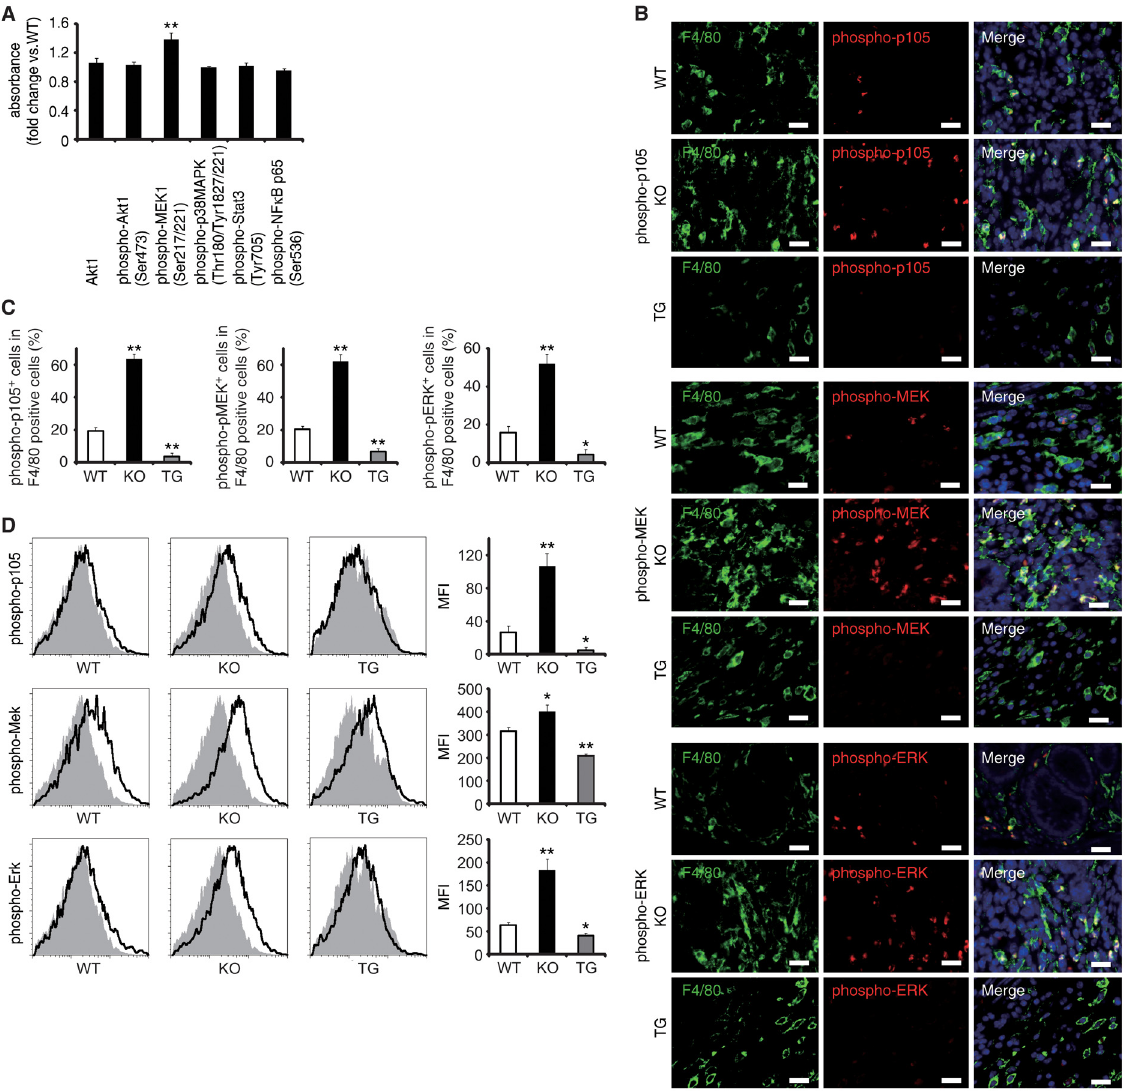
Fig 4. EPRAP inhibits p105 phosphorylation and MEK – ERK activation in stromal macrophages with DSS treatment. (A) The expression levels of Akt1, and phosphorylated forms of either Akt1, MEK1, p38MAPK, Stat3 or NF- κ B p65 in colonic tissue extracts from DSS-treated KO mice compared to WT mice (n = 9 [WT]; n = 7 [KO]). (B) Double-color immunofluorescence analyses of rectal sections from DSS-treated WT, EPRAP-deficient (KO), and CD68 – mEPRAP transgenic (TG) mice. Samples were immunostained with anti-F4/80 (green) and anti – phospho-p105 (red, top), anti – phospho-MEK (red, middle), or anti – phospho-ERK (red, bottom) antibodies. Scale bars: 20 μ m. (C) The percentages of stained cells in F4/80 positive cells. (n = 5 each). (D) Lamina propria macrophages were isolated from the colonic tissues of WT, KO, and TG mice with DSS treatment. Cells were analyzed by flow cytometry, with detection of phospho-p105 (top), phospho-MEK (middle), or phospho-ERK (bottom) (open histograms). Cells were also stained with isotype control antibodies (solid histograms). Figures are representative histograms performed in quintuplicate (left). The levels of phosphorylated forms of p105 (top), MEK (middle), and ERK (bottom) in viable cells from WT, KO, and TG mice were determined as the geometric mean fluorescence intensity (MFI) of the target antibody minus the MFI of the isotype control (right) (n = 5 each). All values represent means ± SEM. ** P < 0.01 vs. WT mice.